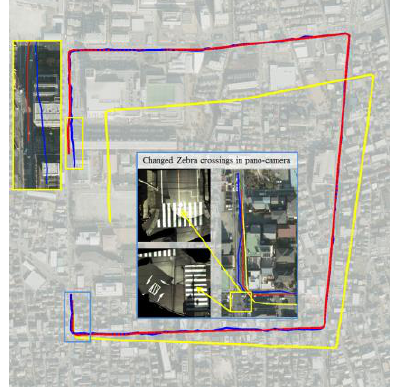
Figure 5. results of particle filtering method